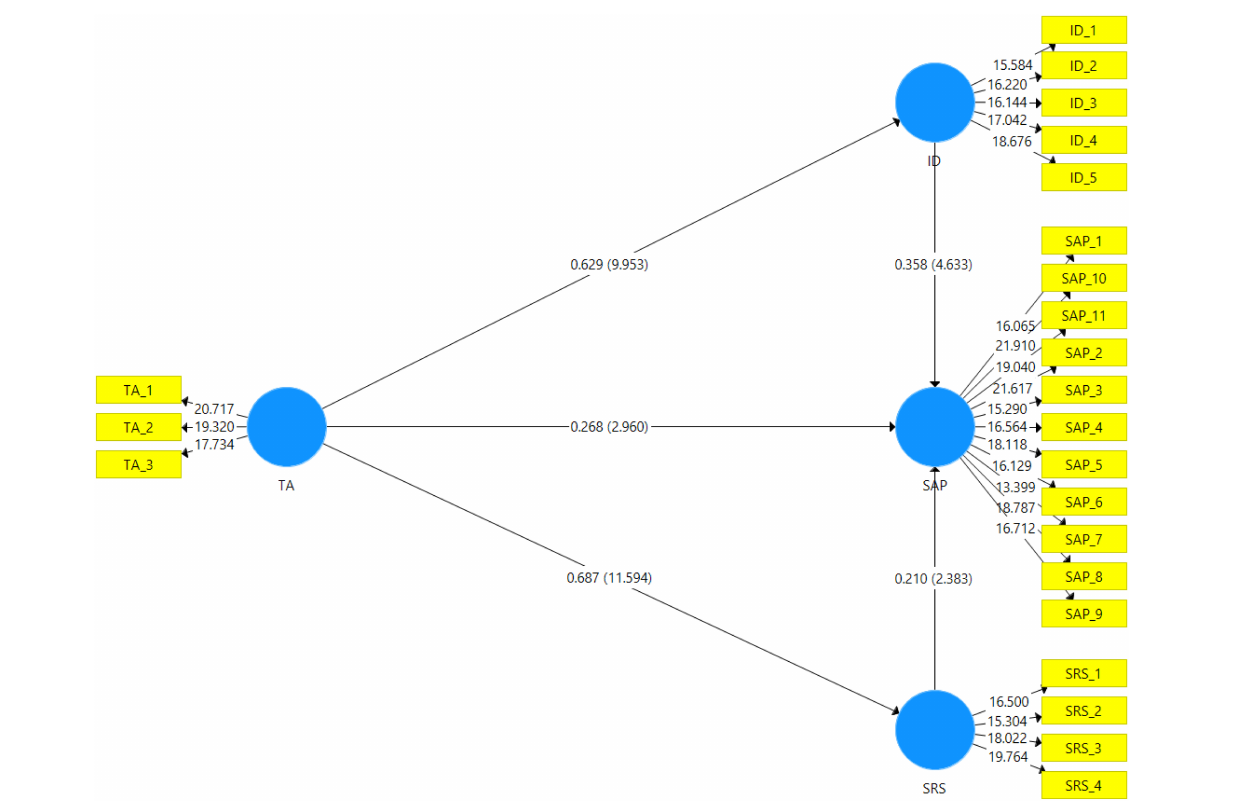
FIGURE 3 | Graphical representation of the structural model.